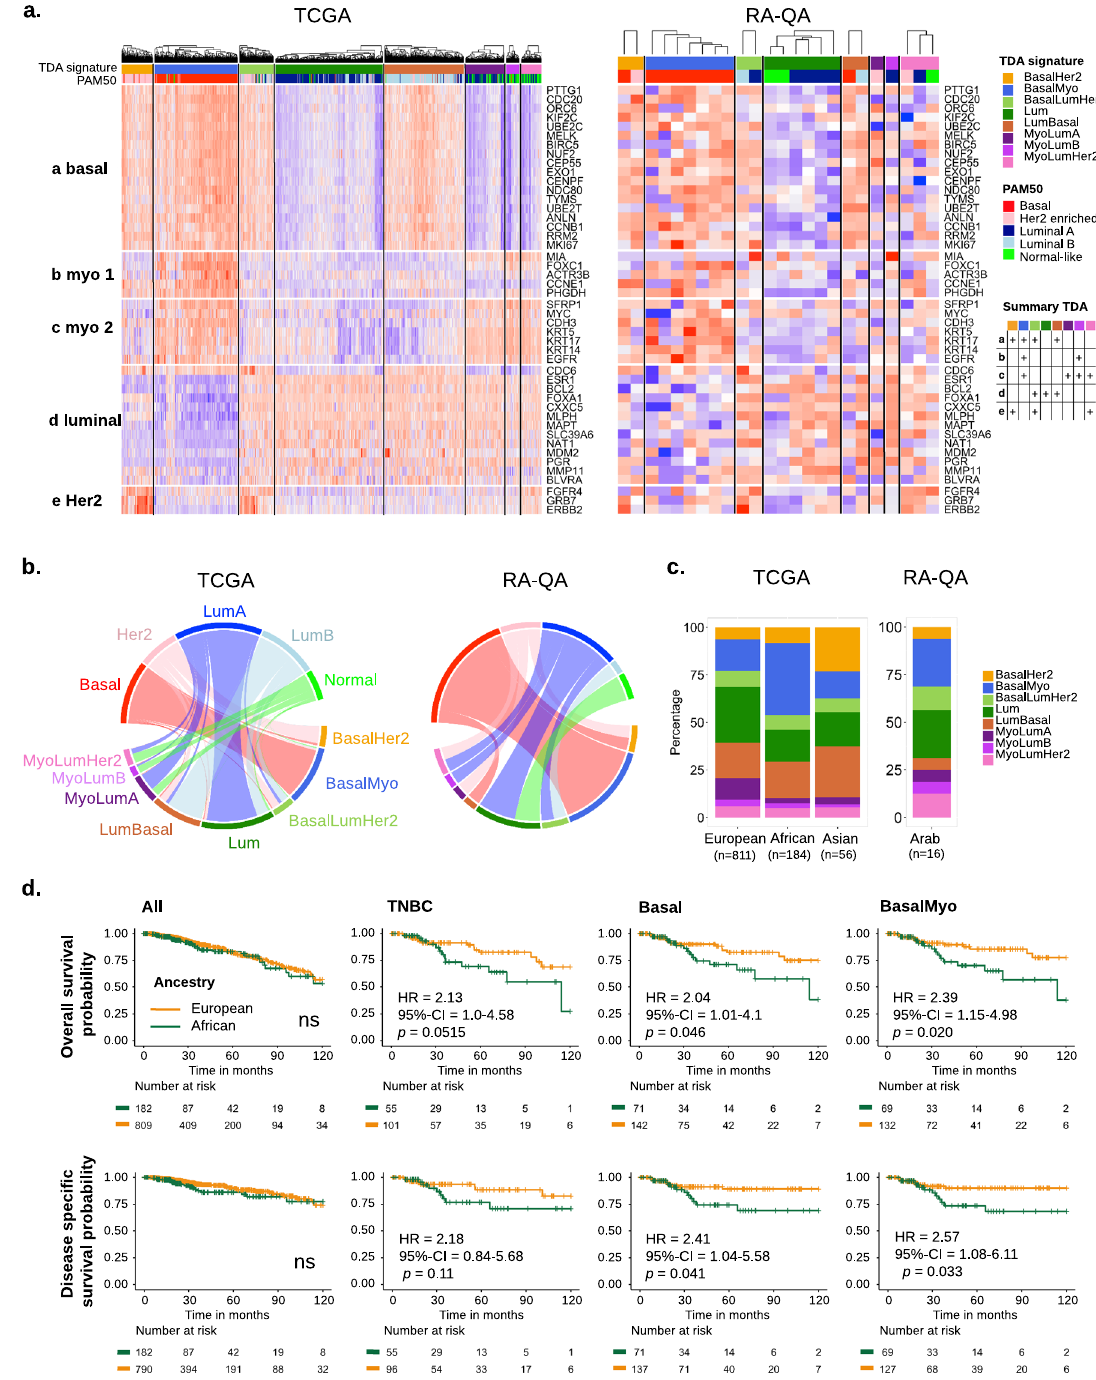
Fig. 1 Distribution of breast cancer molecular subtypes de fi ned by topological data analysis (TDA) signatures across ancestries. a Heatmap of expression of PAM50 genes organized by TDA signature classes in TCGA breast cancer and RA-QA cohort. Samples are annotated by TDA signature class (upper annotation bar) and classical PAM50 intrinsic molecular subtype (lower annotation bar). The combination patterns of upregulated expression of fi ve distinct gene groups de fi ning each TDA class are summarized in a table on the right (Summary TDA). b Reclassi fi cation of breast cancer samples from classical PAM50 intrinsic molecular subtypes (upper part of circos) to TDA signature classes (lower part of circos) in TCGA and RA-QA breast cancer cohorts. c Stacked bar chart of distribution of TDA classes by ancestry. d Kaplan – Meier plots showing overall survival (upper panels) and disease-speci fi c survival (lower panels) by ancestry. Difference between the survival of patients with European and African ancestry is shown for the complete TCGA breast cancer cohort (left), patients with TNBC according to hormone receptor status (middle left), patients with PAM50-de fi ned basal breast cancer (middle right), and patients with tumors classi fi ed as BasalMyo by TDA classi fi cation (right). Censor points are indicated by vertical lines.